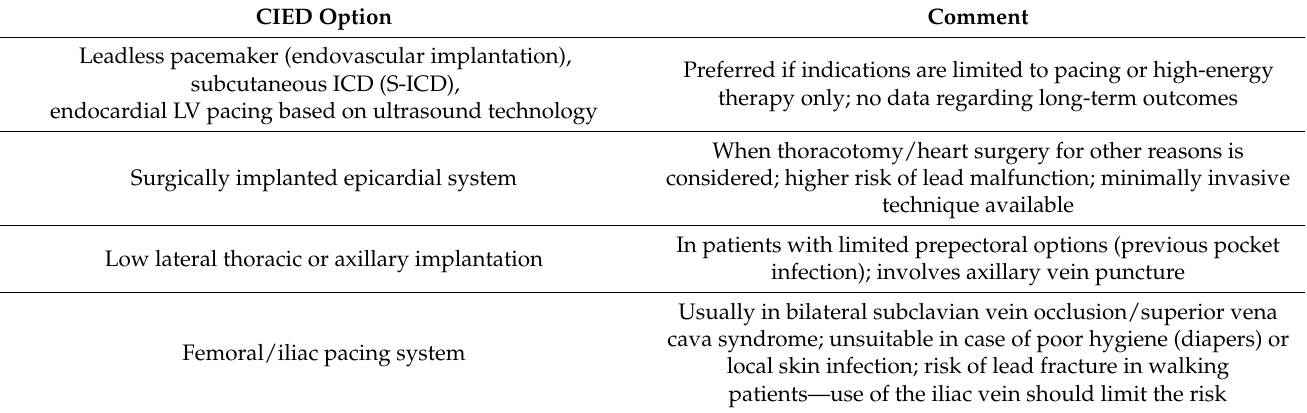
Table 1. Alternative (to standard prepectoral) CIED placement options to consider in patients with